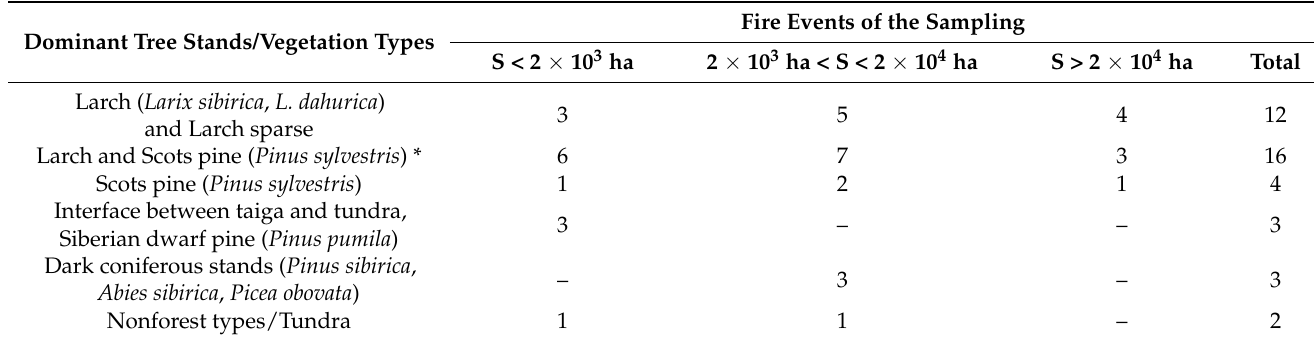
Figure 2. An example of pre-processing Landsat-8/OLI survey data for the pre-fire polygon in 2020 ( a ) and the post-fire polygon in 2021 ( b ). The classification of the fire scar in terms of dNBR ranges ( c ). The shape of the fire scar is shown both based on satellite detecting data (colored in white) and according to the result of classification (colored in red). Table 3. The initial sample of fire events by dominant tree stands/vegetation types. Fire events have been categorized in terms of area burned (S).